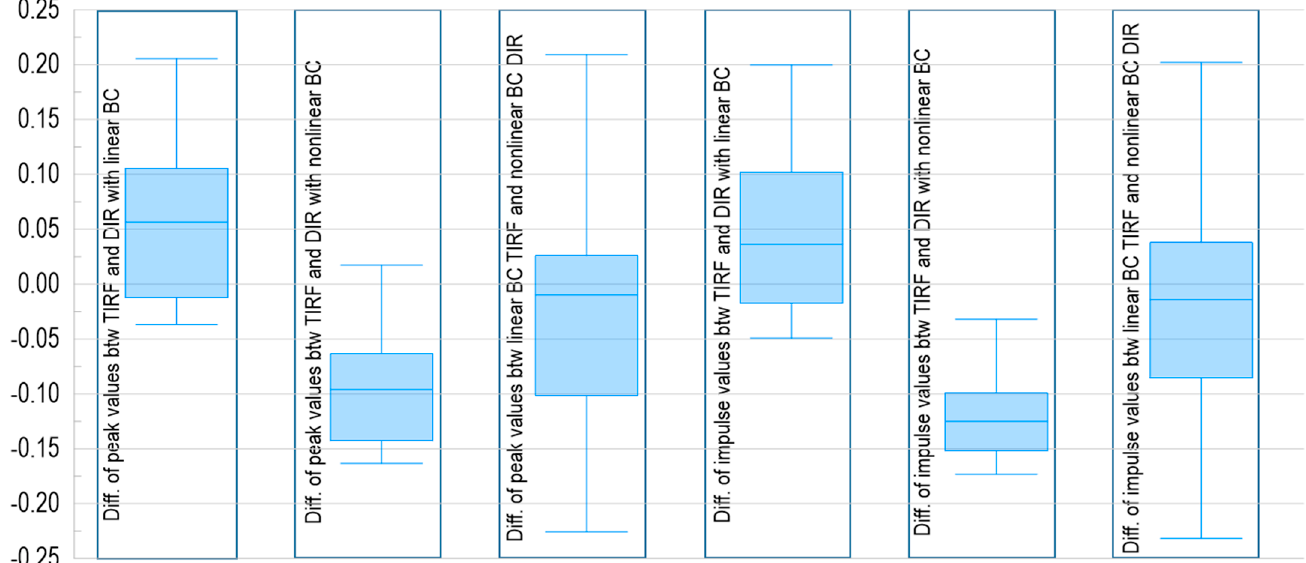
Figure 21. Box and whisker plots for the difference in the peak shear stresses and impulse values using TIRF and DIR. Table 9. Shear responses for LNG cargo containment boxes with hull structure (Model 3).